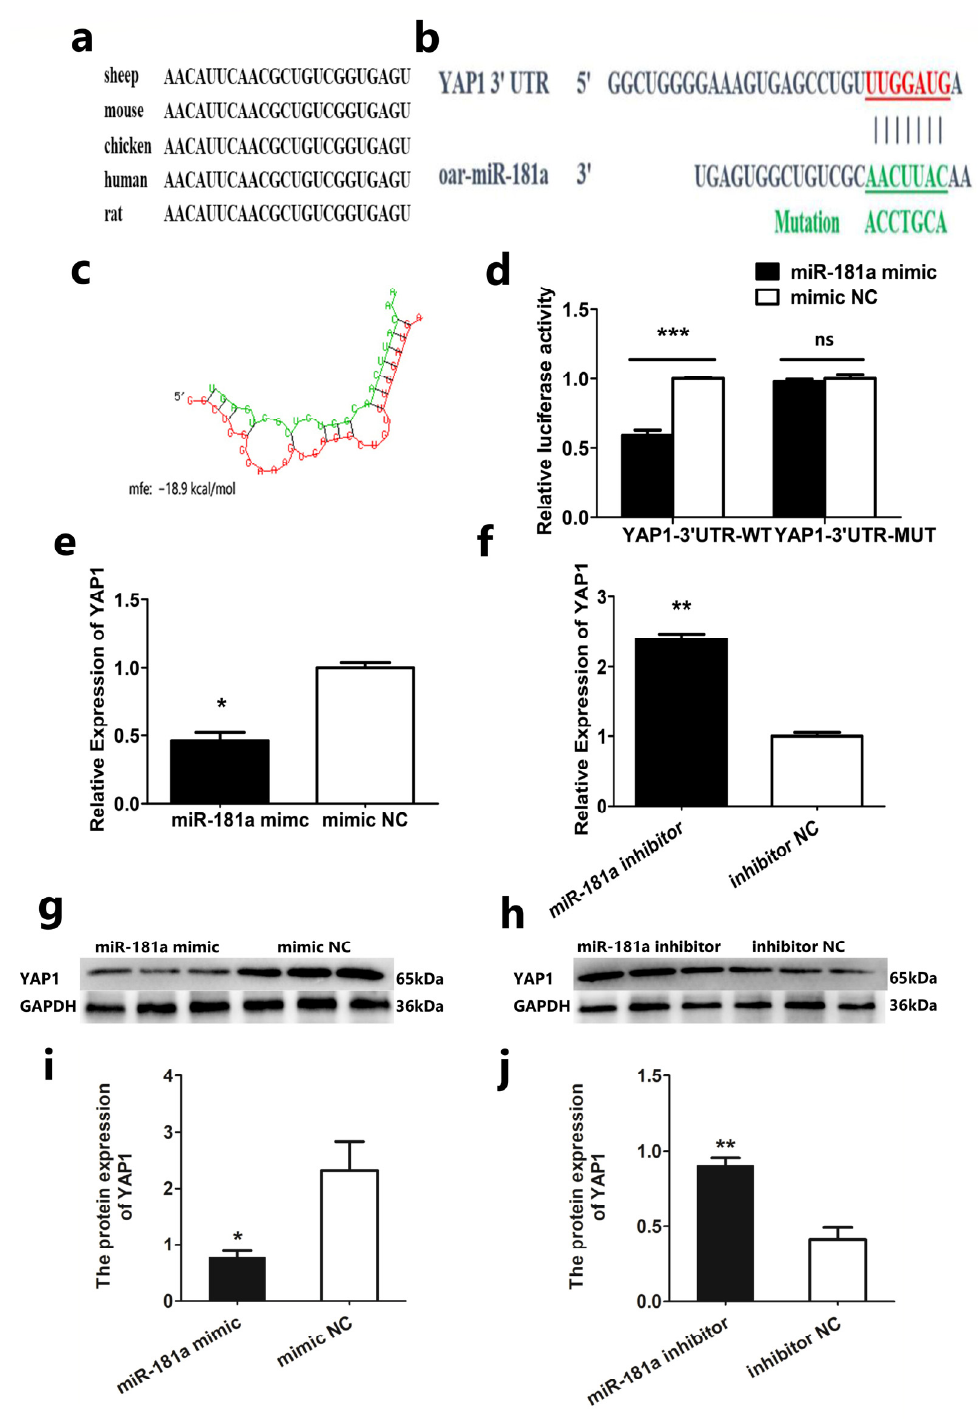
Figure 3. YAP1 is a Target Gene of miR-181a: ( a ) Homology analysis of miR-181a in different species; ( b ) RNAhybrid predicted the targeted binding relationship between YAP1 and miR-181a; ( c ) The interaction model between miR-181a and YAP1 3 ′ UTR by RNAhybrid online software; ( d ) The luciferase assays of HEK293T; ( e , f ) The mRNA expression of YAP1; ( g , h ) The protein expression of YAP1; ( i , j ) Statistical analysis of ( g , h ). In all graphs, all data are presented as means ± SEM (standard error of the mean) ( n = 3). Statistical significance was performed by unpaired Student’s t-test. (* p < 0.05; ** p < 0.01; *** p < 0.01; ns p > 0.05) vs. NC (negative control).